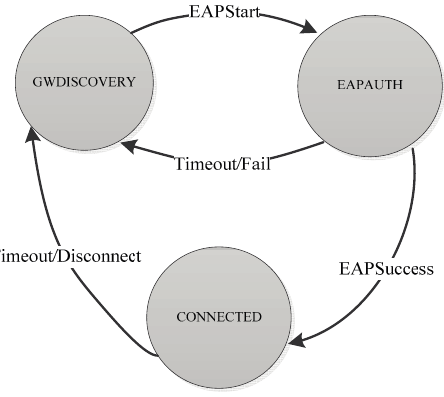
Figure 4. Sensor node connection states and state transitions when connecting to a new sensor